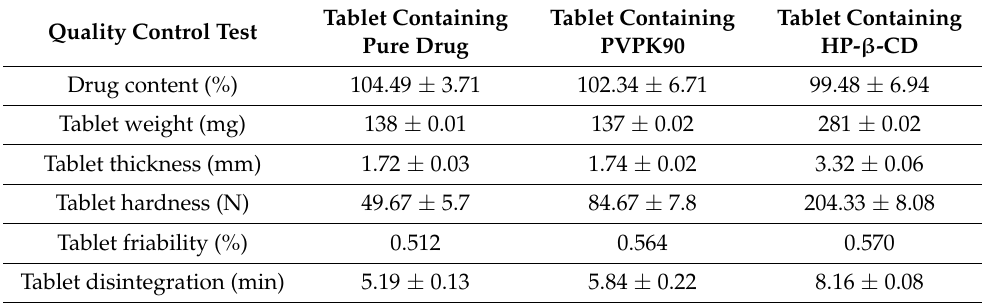
Table 1. Quality control tests of the prepared PP10